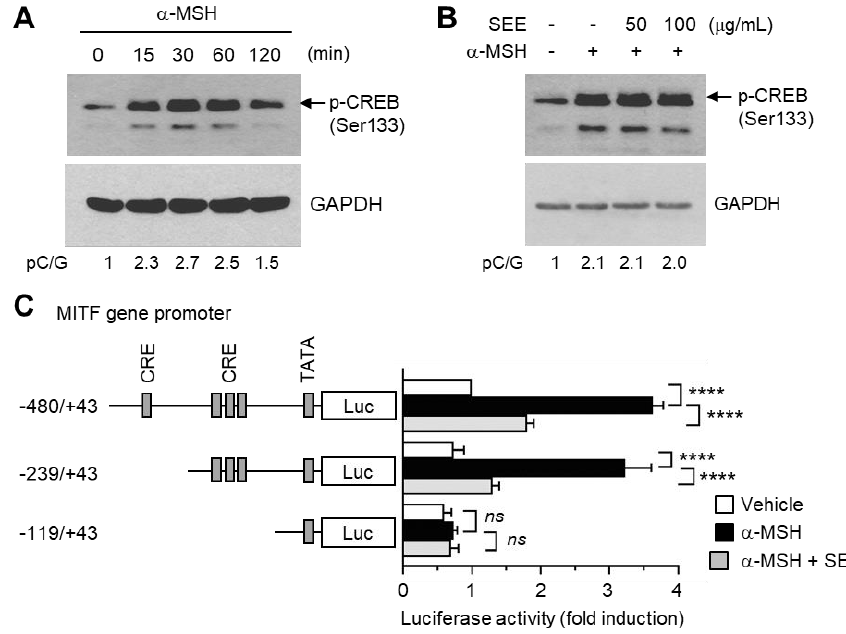
Figure 4. Effect of SEE on the inhibition of α -MSH-induced MITF promoter activity. ( A ) B16F10 cells were treated with 100 nM α -MSH for various times (0–120 min), and cell lysates were subjected to immunoblotting using an antibody against phospho-cAMP response element-binding protein (CREB) (Ser133). The glyceraldehyde 3-phosphate dehydrogenase (GAPDH) level was examined as an internal control. ( B ) B16F10 cells were treated with either vehicle (DMSO) or SEE (50 or 100 µ g/mL) for 30 min, followed by stimulation with 100 nM α -MSH. After 30 min, cell lysates were subjected to immunoblotting using an antibody against phospho-CREB (Ser133). The GAPDH level was examined as an internal control. The intensity of the bands was quantified using ImageJ and the relative p-CREB intensity was normalized to that of GAPDH and visualized in the blot. pC/G, p-CREB/GAPDH. ( C ) B16F10 cells were transfected with 0.2 µ g of a series of 5 (cid:48) -deletion constructs of the MITF gene promoter reporter plasmids. Forty-eight hours later, the cells were treated with either vehicle (DMSO), 100 nM α -MSH, or α -MSH plus 50 µ g/mL SEE for 8 h, and the luciferase activities were measured. The data shown represent the mean ± SD ( n = 3). **** p < 0.0001; ns , not significant. The MITF gene contains multiple regulatory regions within the 5 (cid:48) -flanking region 2.5. SEE Downregulates Pax3 Expression to Inhibit α -MSH-Induced MITF Promoter Activity